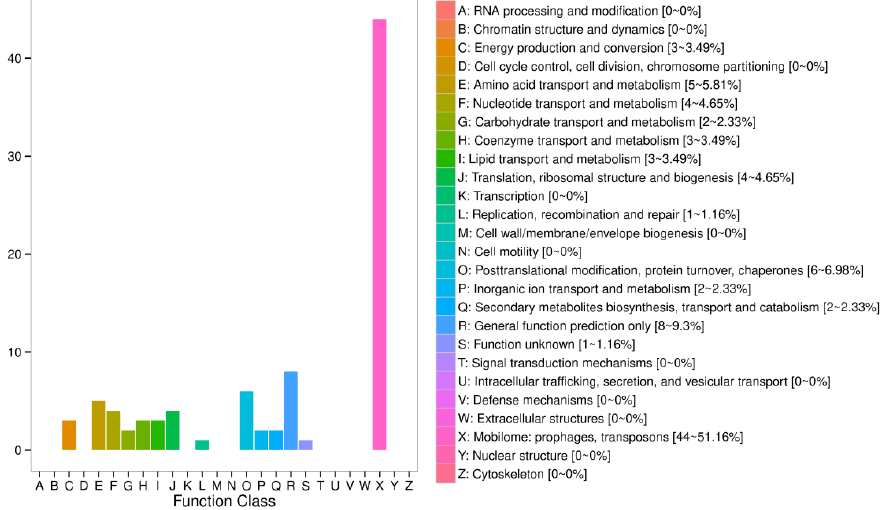
Figure 2. COG analysis of the new genes. (X-axis: the COG functional classifications. Y-axis: the new genes number in each COG functional classifications. On the right are listed the functional categories corresponding to each number, the number of new genes in this category and the proportion of the total number of new